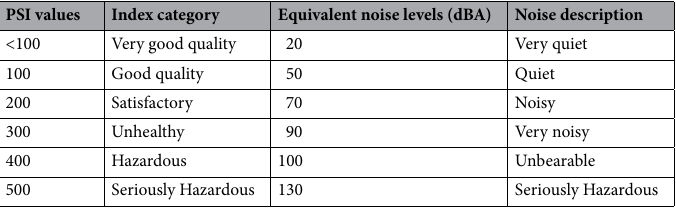
Table 10. The breakpoints used to define sub-indices (standard index for noise